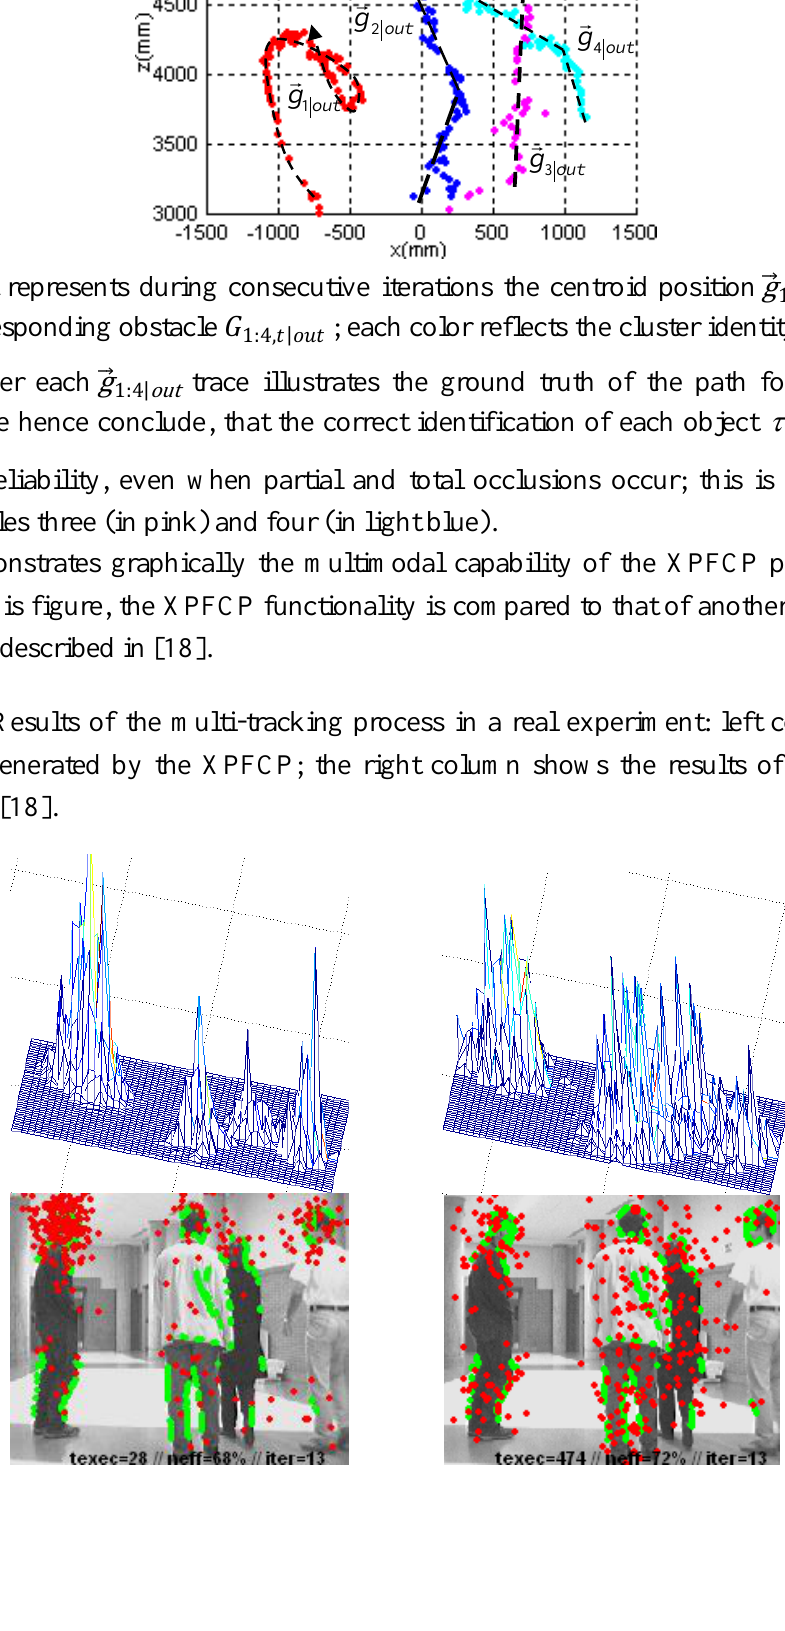
Figure 10. Trajectory followed in the ground plane (XZ) by four obstacles according to the XPFCP estimation results in a real experiment.